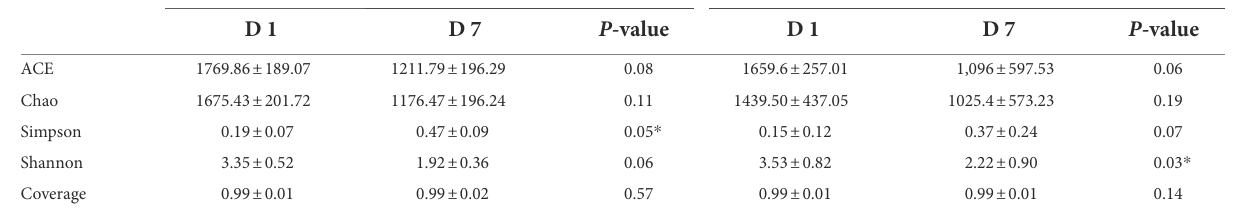
TABLE 3 Alpha diversity indices for milk microbiota.